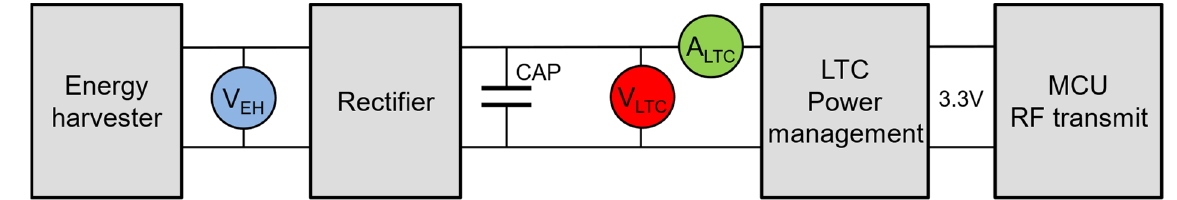
Figure 13. Schematic diagram of energy harvesting system with highlighted electrical parameters measurement.